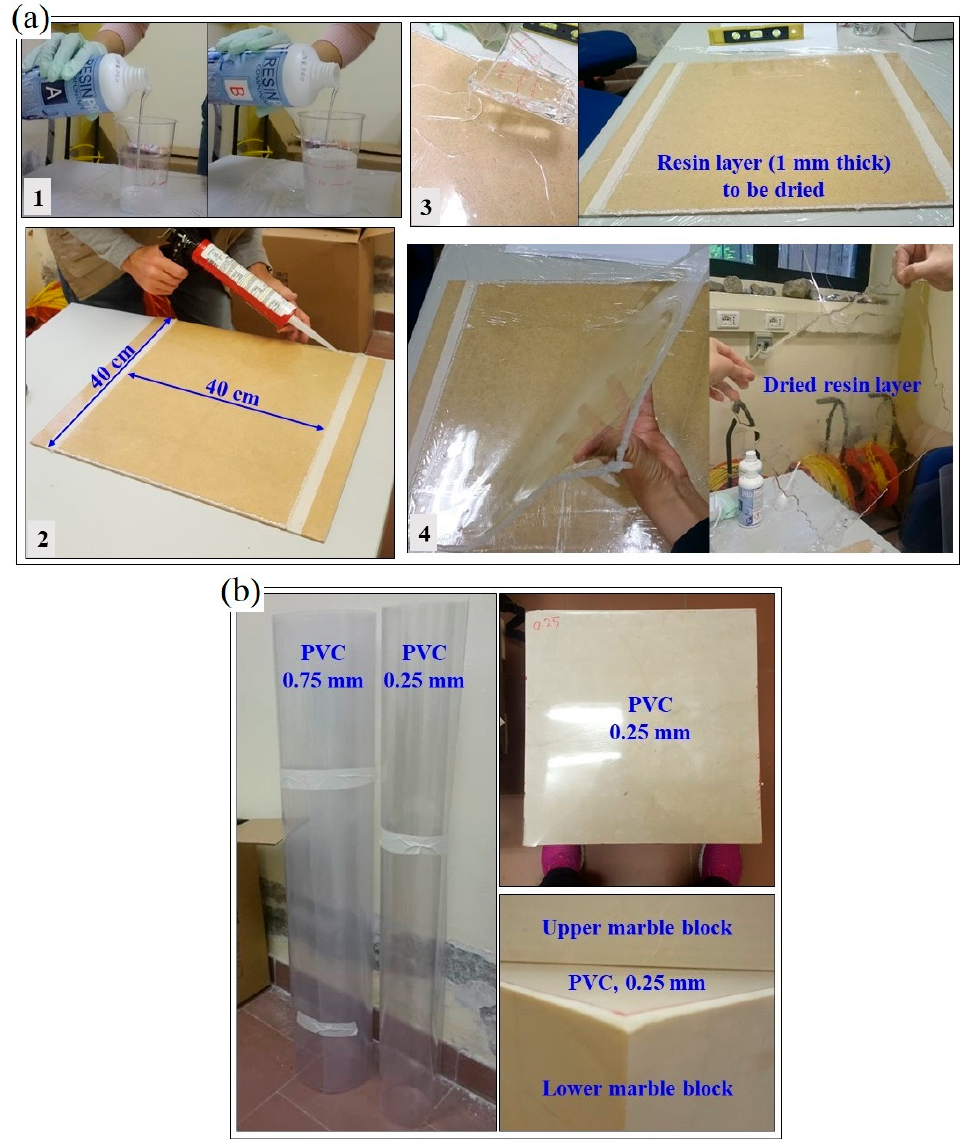
Figure 3. ( a ) The procedure to prepare resin sheets with the thickness of 1 mm in the laboratory: 1. Mixing resin components; 2. Preparing a flat surface covered by a plastic film and adding adhesive silicone side walls; 3. Pouring the volume of resin required to prepare a 40 × 40 × 0.1 cm layer, always keeping the surface horizontal; 4. Detaching the dried resin layer. ( b ) PVC material that was used instead of resin in the fractures (block contacts).